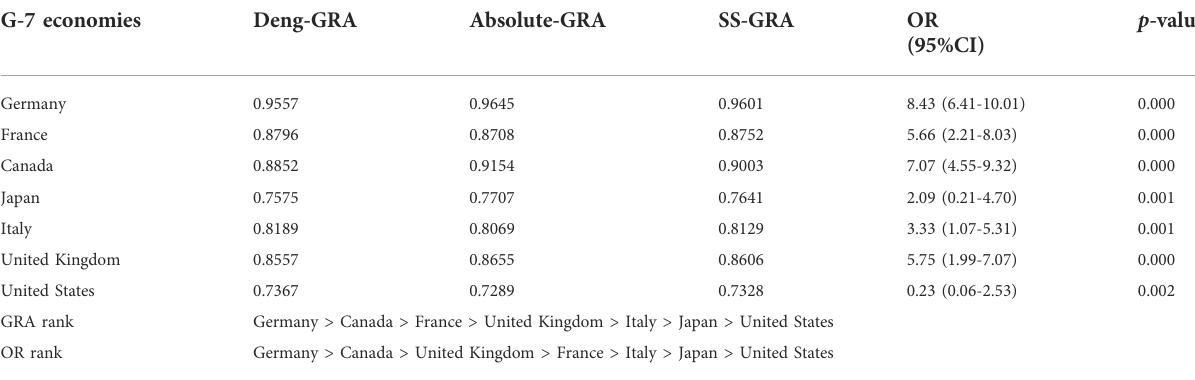
TABLE 4 Mathematical and statistical assessment between carbon emissions and trade openness.